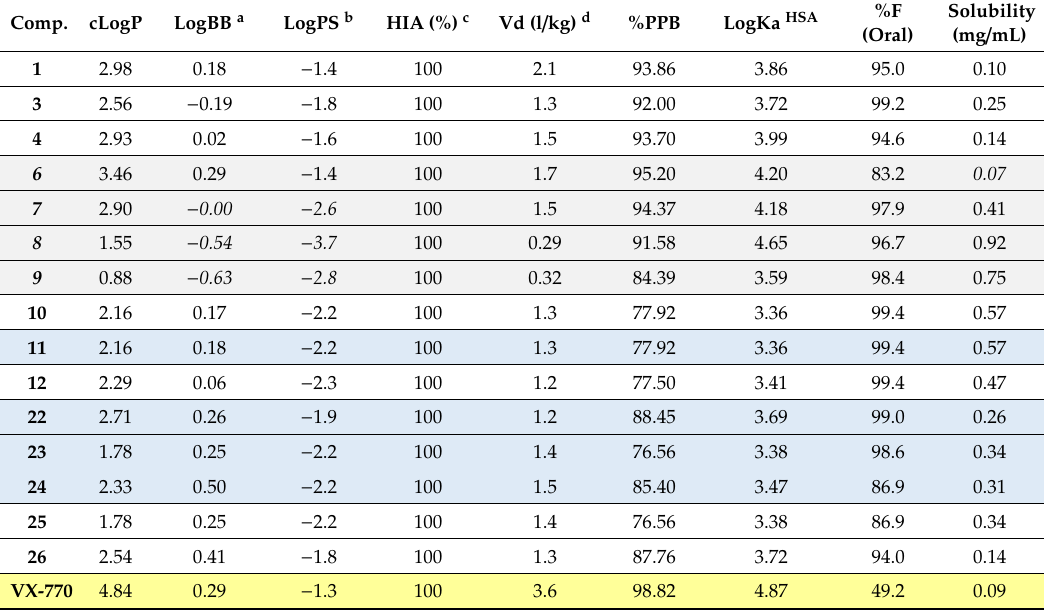
a Extent of brain penetration based on ratio of total drug concentrations in tissue and plasma at steady-state conditions. b Rate of brain penetration. PS represents Permeability-Surface area product and is derived from the kinetic equation of capillary transport. c HIA represents the human intestinal absorption, expressed as percentage of the molecule able to pass through the intestinal membrane. d prediction of Volume of Distribution (Vd) of the compound in the